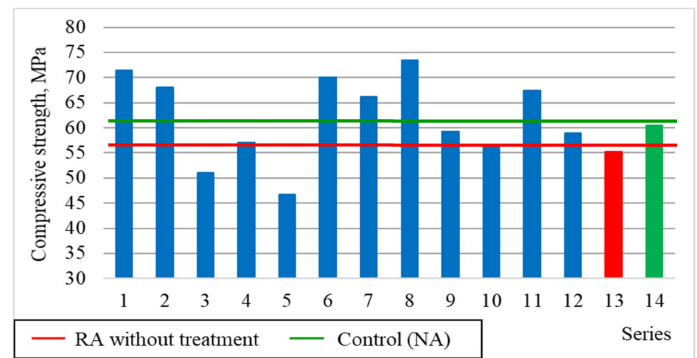
Figure 4. The compressive strength of concretes compared with series 13 and 14.